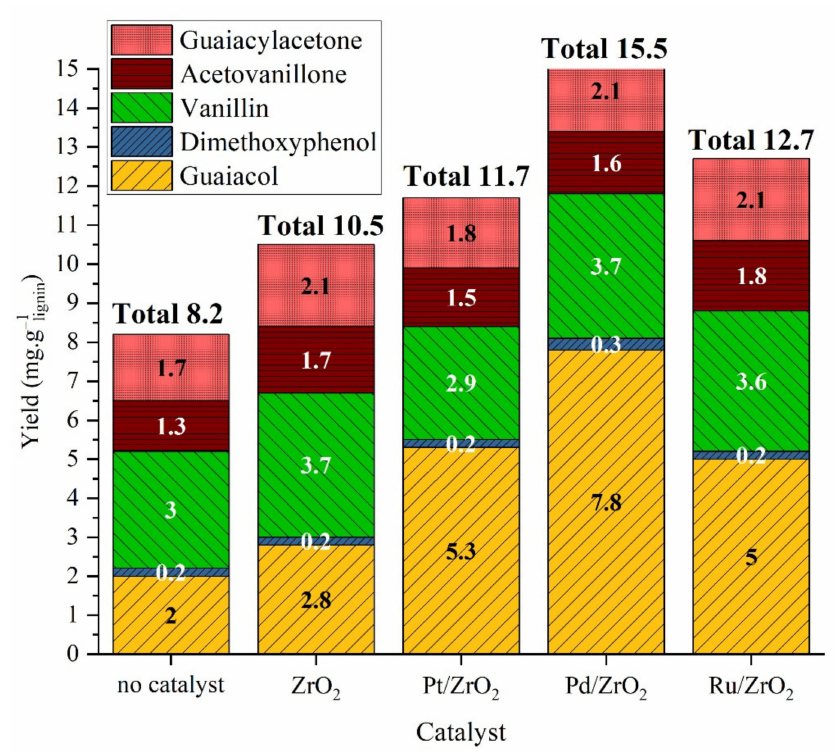
Figure 7. Yield of monomeric products in organic phase after lignin catalytic liquefaction over metal catalysts. Reaction conditions: Kraft lignin 10 g · L − 1 , mass ratio Pt/lignin 1/100 or molar equivalent, 3 h, 225 ◦ C, 40 bar